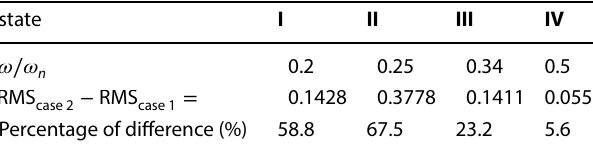
Table 2 The differences vibration level due to the support move- ment